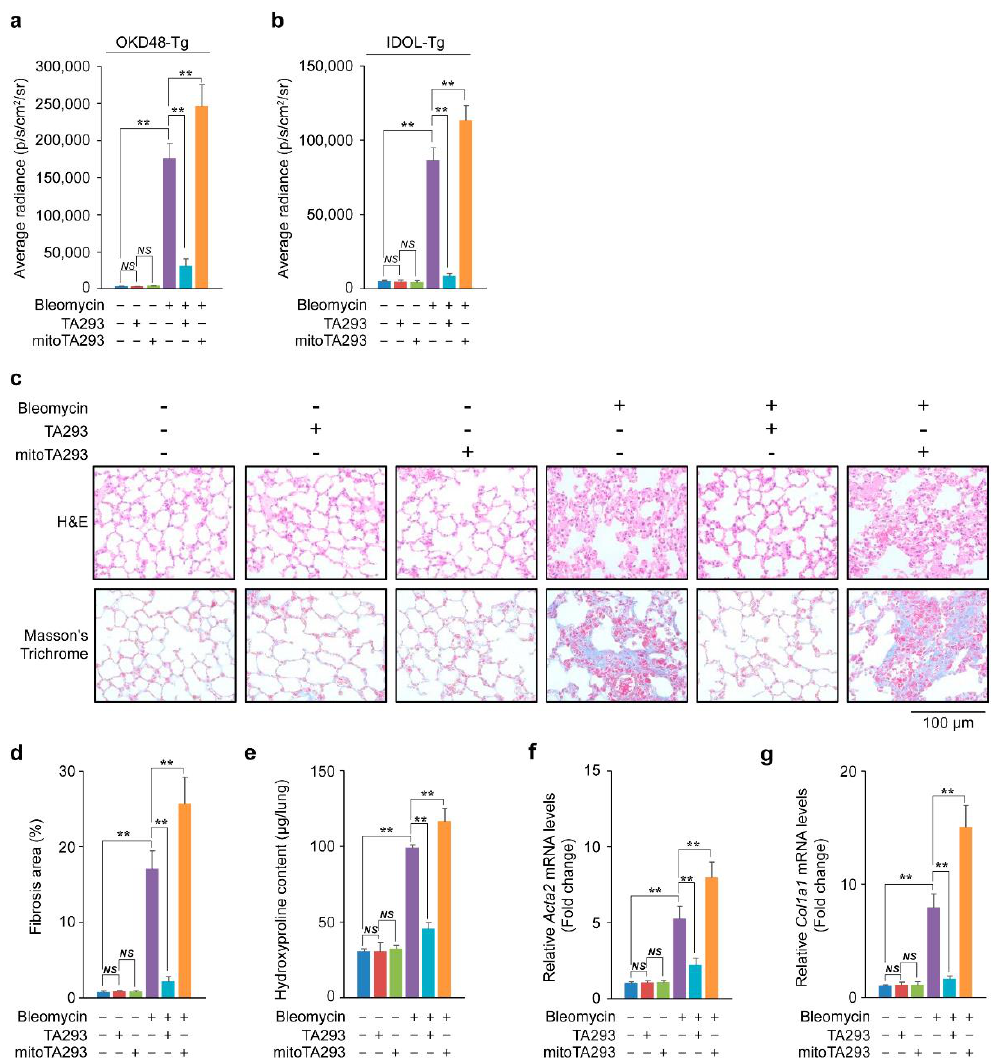
Figure 1. Effects of TA293 and mitoTA293 on oxidative stress, inflammation, and fibrosis in bleomycin (BLM)-induced pulmonary fibrosis model mice. Quantification of ( a ) oxidative stress and ( b ) inflammation in vivo. ( c ) Histopathology (hematoxylin and eosin (H&E) staining) and fibrosis (Masson’s trichrome staining) in mice 14 days after BLM administration. Pulmonary fibrogenesis was evaluated by semiquantitative analysis based on ( d ) Masson’s trichrome staining, ( e ) hydroxyproline content, and expression of ( f ) Acta2 and ( g ) Col1a1 mRNAs was determined using qRT-PCR. The data are presented as the mean ± SEM ( n = 5 per group); ** p < 0.01; NS , not